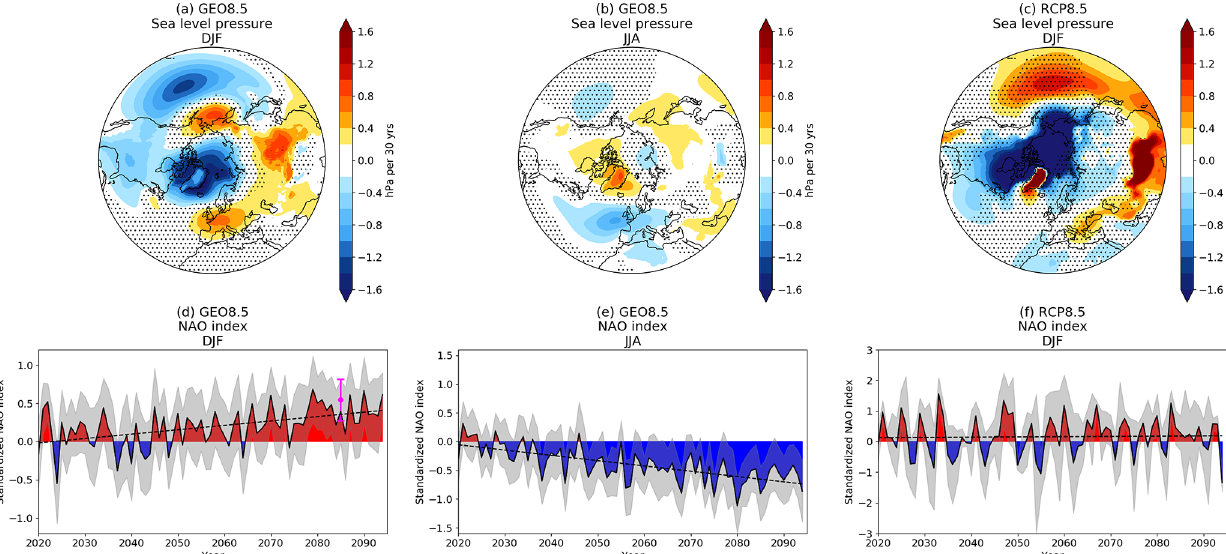
Figure 5. Trends in SLP and the surface (SLP-based) NAO time series. (a, b, c) Ensemble mean linear trends in sea level pressure (hectopas- cals per 30 years). (d, e, f) Ensemble mean time series of the NAO. Responses are shown for (a, d) GEO8.5 (DJF), (b, e) GEO8.5 (JJA) and (c, f) RCP8.5 (DJF). The magenta point in (d) shows the ensemble mean response in GEOHEAT and its 95% confidence interval. Stippling in (a, b, c) indicates lack of statistical significance at the 95% confidence interval under a one sample, two-sided Student’s t test using the standard deviation across ensemble members. The gray shading in (d, e, f) indicates the 95% confidence interval ( ± 2 σ/ number of ensemble members). The vertical scales for the NAO index are different in order to clearly illustrate the respective time series and confidence